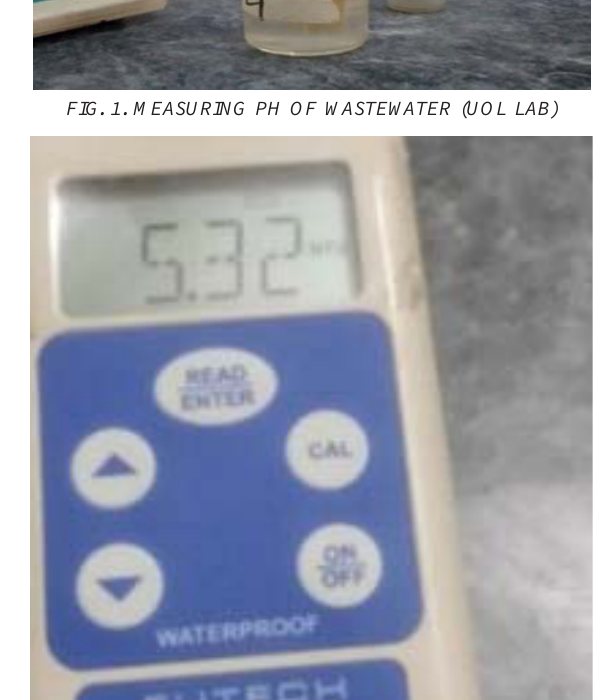
FIG. 2. TURBIDITY METER (UOL